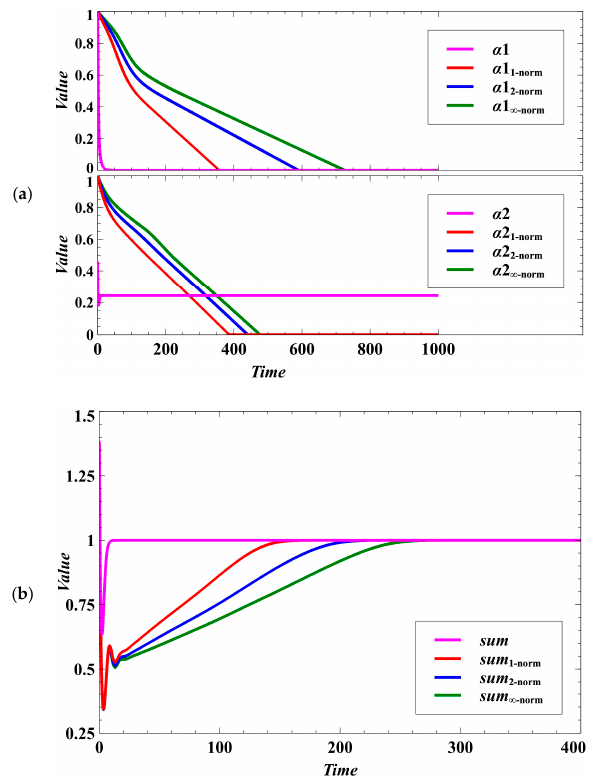
Figure 1. Effect of using different norms in the evolutionary objective under the deterministic case. ( a ) Effect on lowering the parasitism exploitation coefficient. The parameters α 1, α 1 1 − norm , α 1 2 − norm and α 1 ∞ − norm ( α 2, α 2 1 − norm , α 2 2 − norm and α 2 ∞ − norm ) are the parasitism exploitation coefficients for species 1 (species 2) using non-cooperative optimization, Manhattan, Euclidean, and Chebyshev norms, respectively. The figure shows which method converges faster to the desired value α = 0 (no disease). ( b ) In the figure, sum = X 1 + X 2 (for non-cooperative optimization), sum 1 − norm = X 1 1 − norm + X 2 1 − norm , sum 2 − norm = X 1 2 − norm + X 2 2 − norm , and sum ∞ − norm = X 1 ∞ − norm + X 2 ∞ − norm . The desired goal is to maximize the utilization of the resources (sum equals 1). The variables X 1, X 1 1 − norm , X 1 2 − norm , and X 1 ∞ − norm ( X 2, X 2 1 − norm , X 2 2 − norm , and X 2 ∞ − norm ) are the population densities for species 1 (species 2) using non-cooperative optimization, Manhattan, Euclidean, and Chebyshev norms,